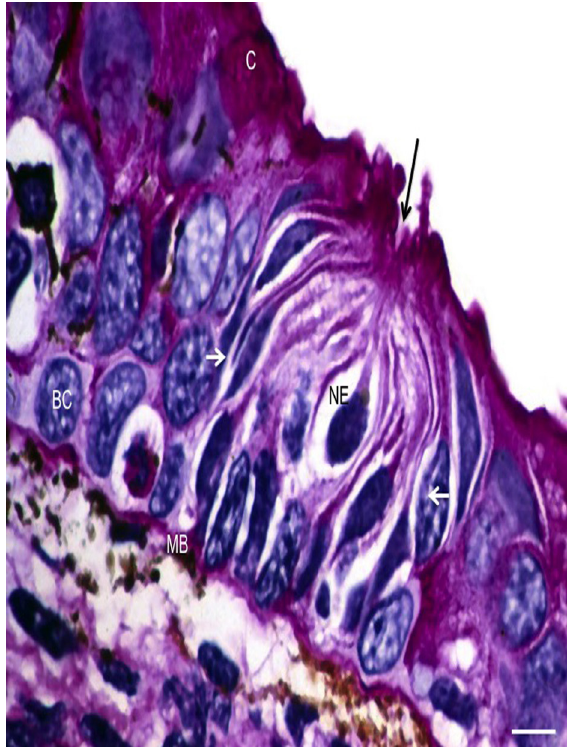
Figure 6 - Skin of dorsocephalic region of L. paradoxa . A mechanoreceptor that occupies the entire thickness of the epidermis. The basal part rests on the basal membrane (MB). The neuroepithelial central cell (Ne) is surrounded by support cells (short arrows) and the basal cells of the Malpighian stratum (BC), and the neuropil reaches the surface (long arrow) through the cuticle (C). PAS. Bar: 20